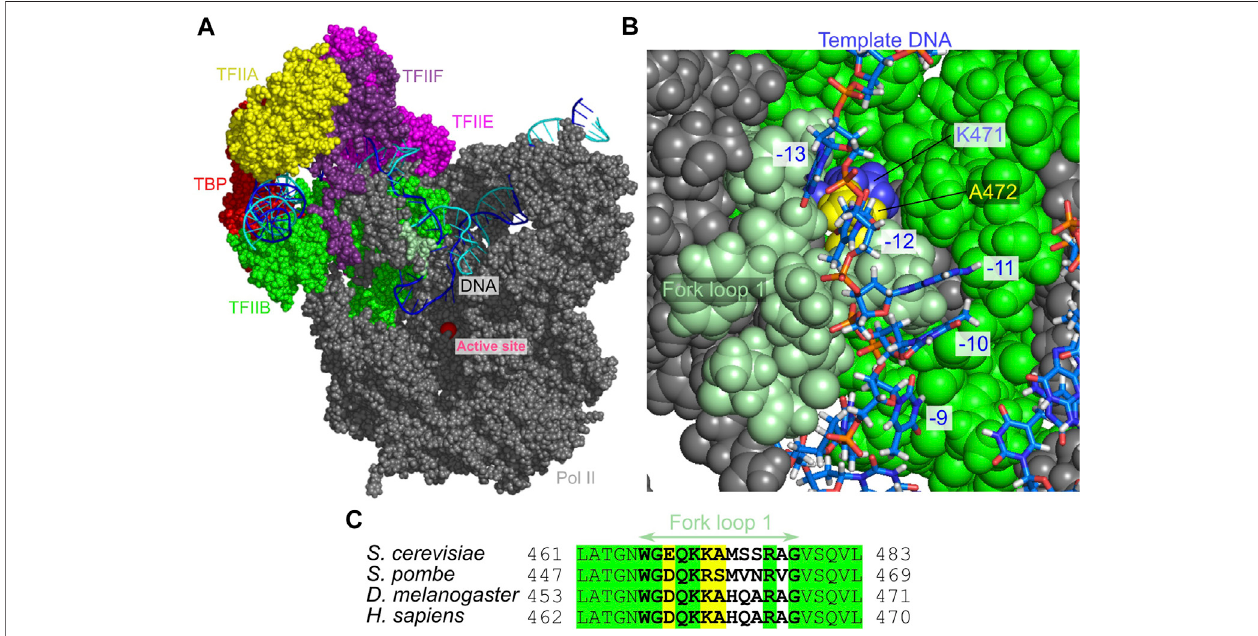
FIGURE5| TheopenDNAintheintermediate stateI 2 . (A) TheatomicstructuremodelfortheI 2 state.SomeproteinsarenotdisplayedtomaketheDNAvisible. (B) The close-up view of the fork loop 1 (pale green) that blocks the template DNA passage. (C) Multiple sequence alignment of the fork loop 1 region of the Rpb2. Green, invariant; yellow,